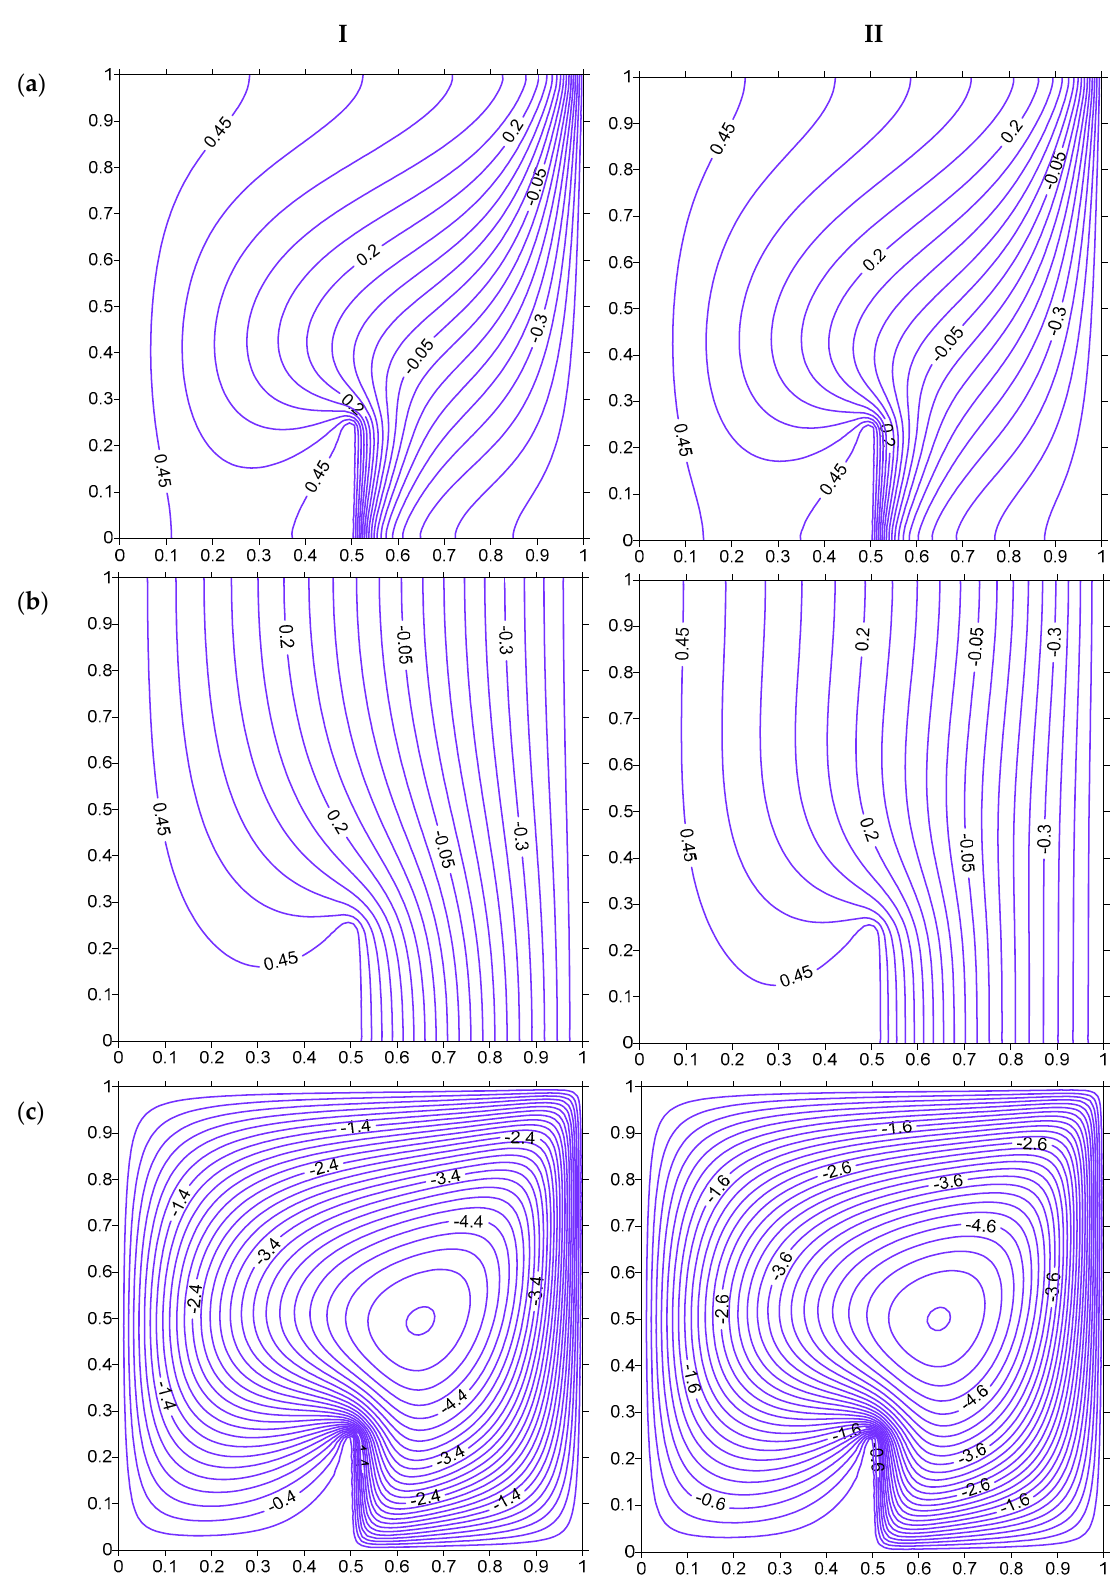
Figure 22. Isotherms (( a ) Fluid, ( b ) Solid), and streamlines ( c ), at Ra = 100, HH = 25%, Kr = 1, Rd = 0 for strip at x = 0.5. ( I ) H = 0.1. ( II ) HH =